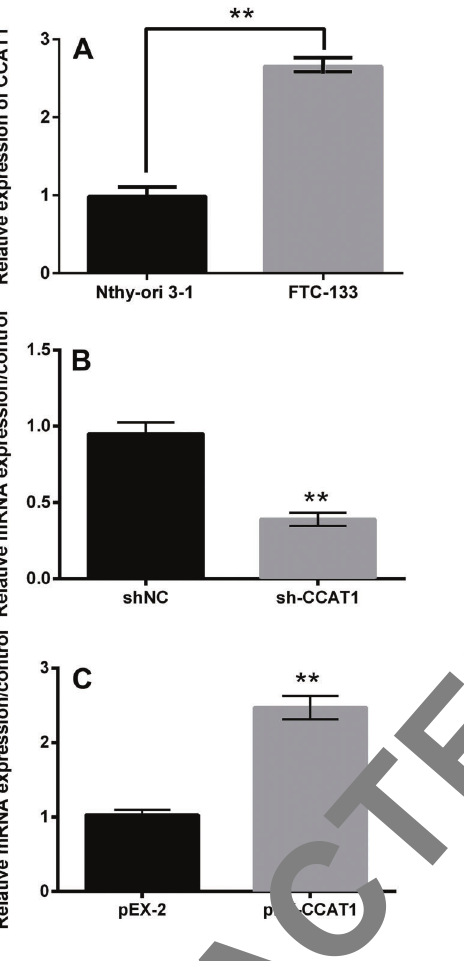
Figure 1. Expression of CCAT1 in FTC-133 cells. Cells were transfected with CCAT1 expressing vector or CCAT1 shRNA. A , The mRNA level of CCAT1 was detected using qRT-PCR in Nthy-ori 3-1 cells and FTC-133 cells. B and C , The expression level of CCAT1 suppression and overexpression were tested by using qRT-PCR in FTC-133 cells. NC: negative control. Data are reported as means ± SD. **P o 0.01